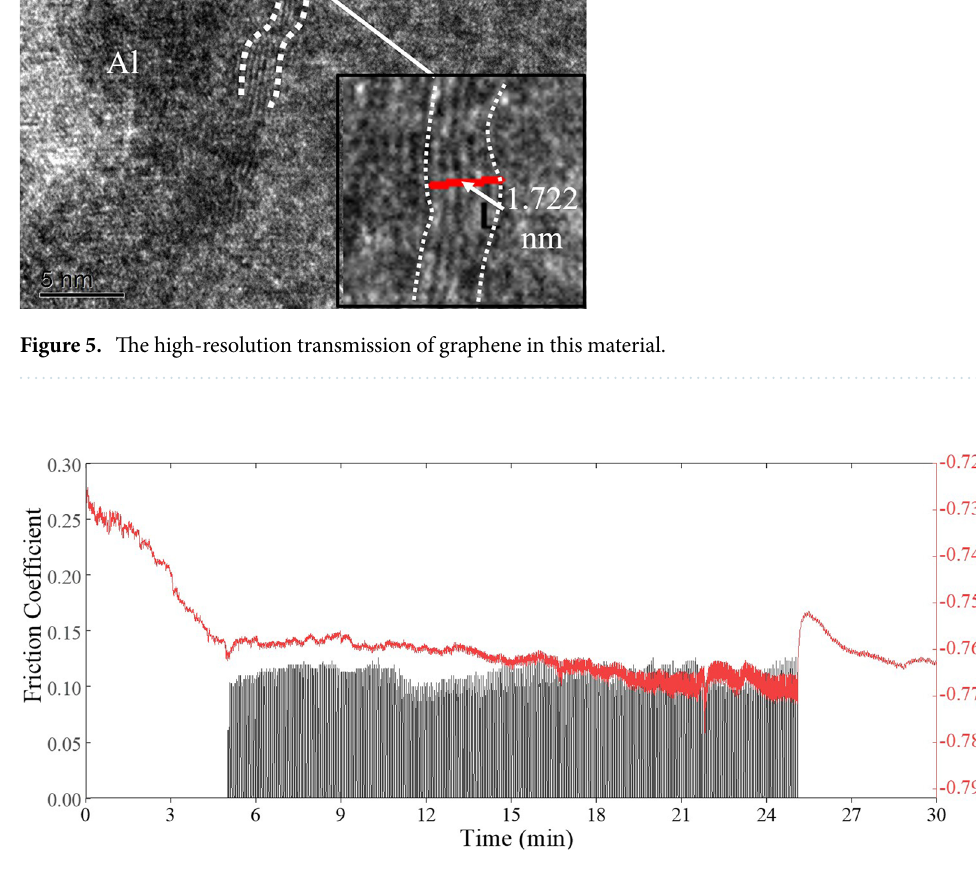
Figure 6. The friction coefficient and OCP of GAMCs over